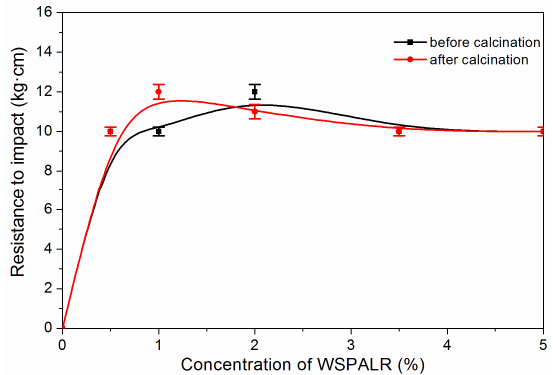
Figure 8. Effect of WSPALR and high-temperature calcined WSPALR on the resistance to impact of coatings.